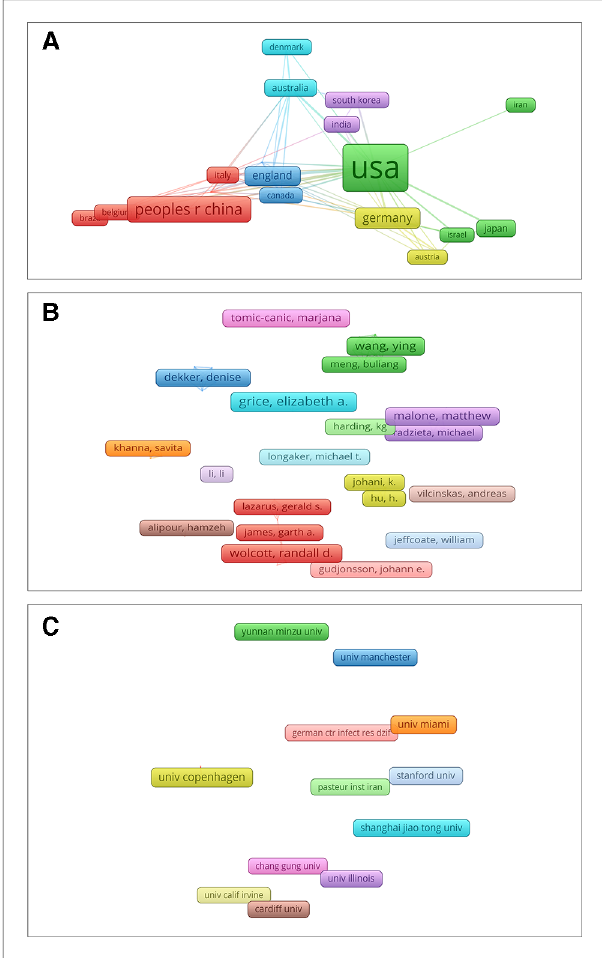
FIGURE 6 Mapping of co-authorship analysis about HTS technology associated with chronic wounds. ( A ) Mapping of the 20 identi fi ed countries. ( B ) Mapping of the 55 identi fi ed authors. ( C ) Mapping of the 30 identi fi ed institutions.